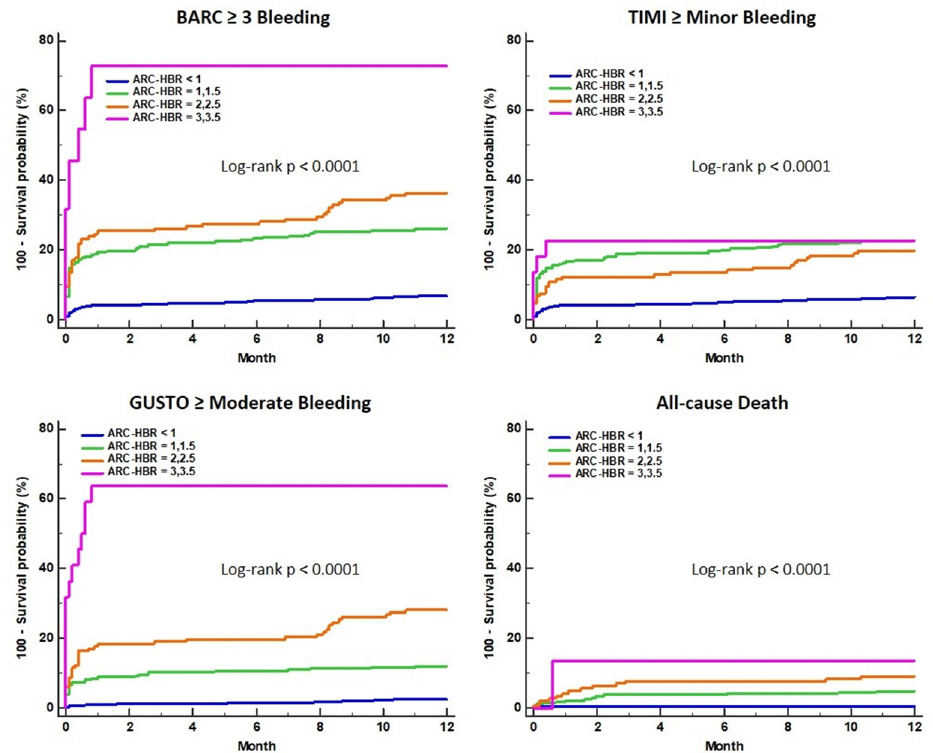
Figure 2. Cumulative incidence curve of clinical outcomes for different ARC-HBR scores. ARC-HBR, Academic Research Consortium for High Bleeding Risk criteria; BARC, Bleeding Academic Research Consortium; GUSTO, Global Use of Strategies To Open coronary arteries; TIMI, Thrombolysis in Myocardial